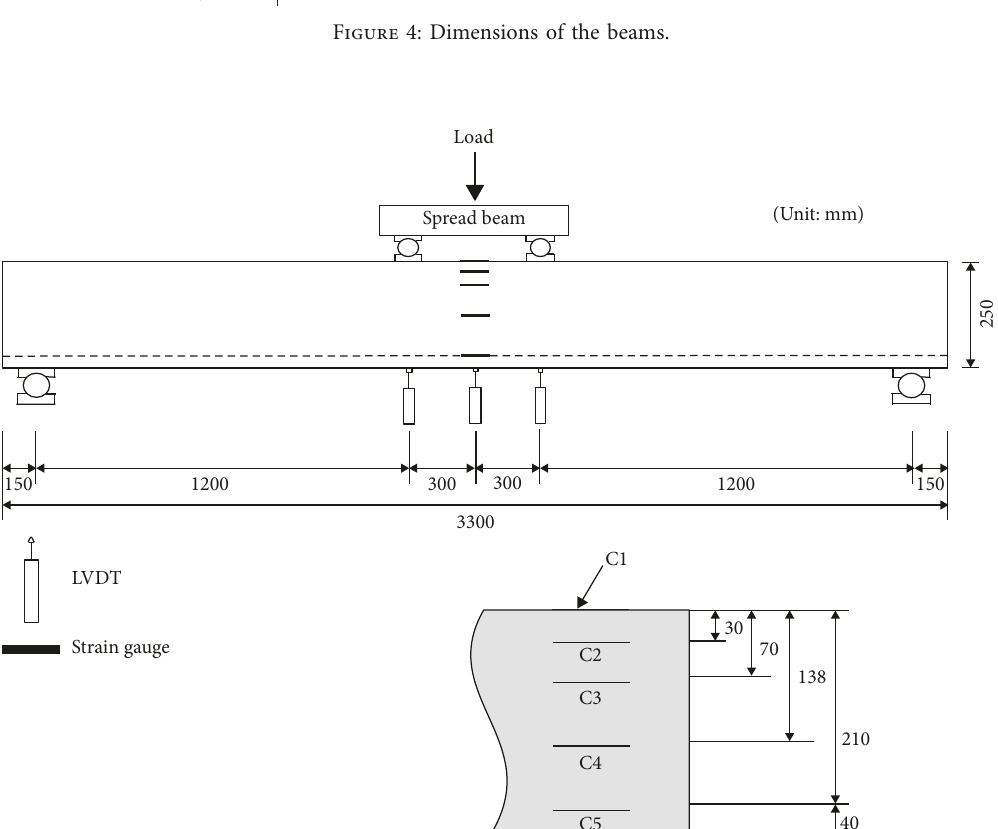
Figure 5: Instrumentation used for the flexural tests of the beams.